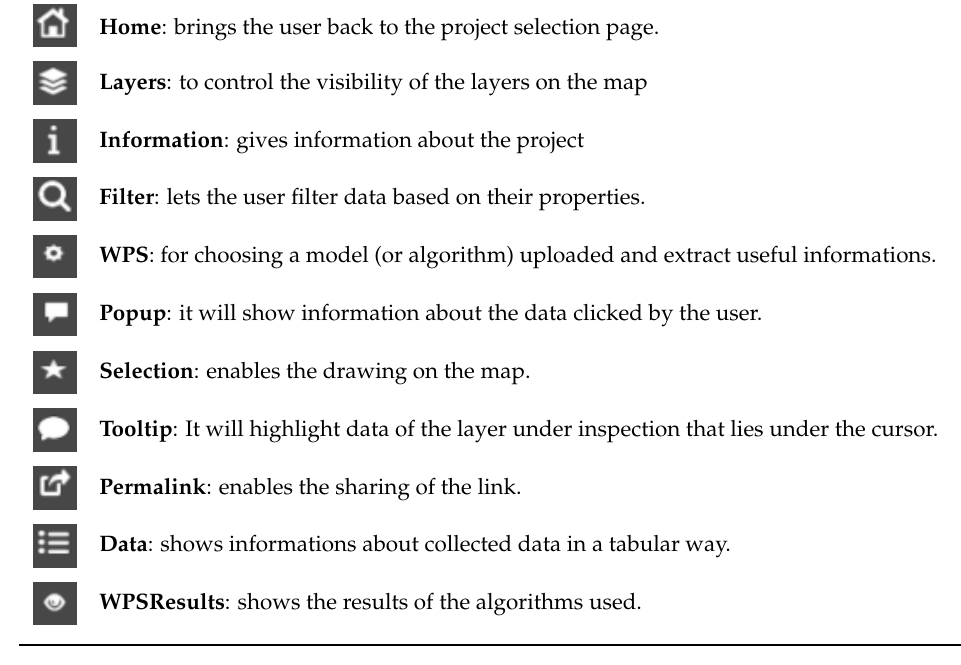
Table 1. Utilities included in the web-map.